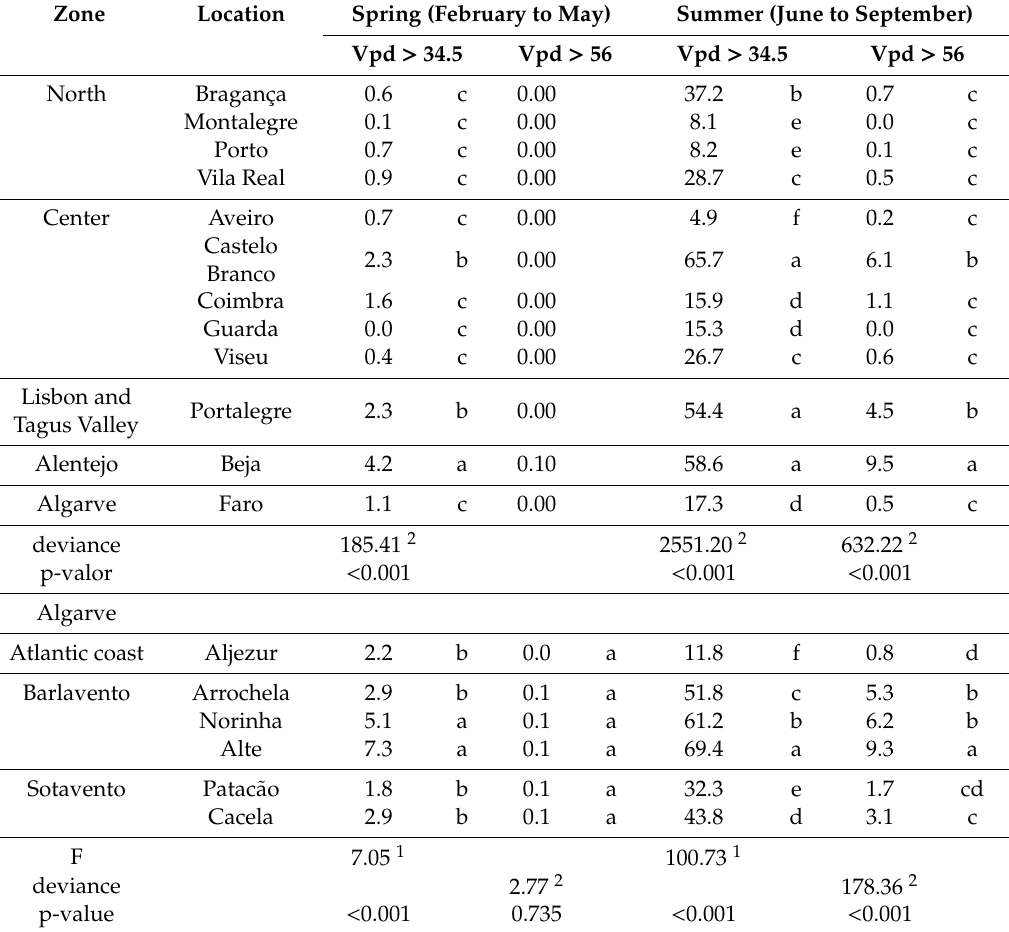
Table 2. Mean number of days with water vapor pressure deficits (vpd) above 34.5 and 56.0 mbar in areas of mainland Portugal in the spring and summer from 2004 to